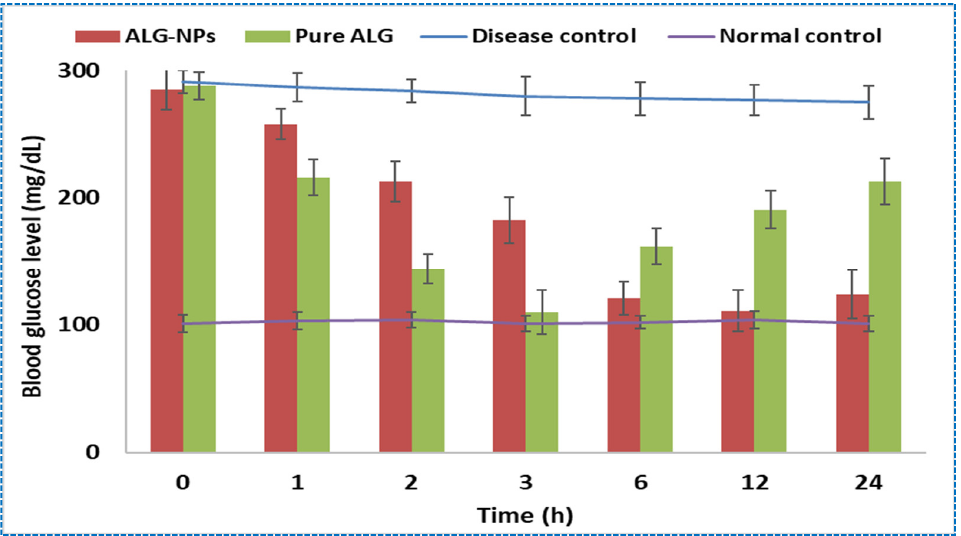
Figure 10. Comparative antidiabetic profile of pure ALG and optimized ALG-NPs. Each study performed using six animals and data presented as mean ± SD.